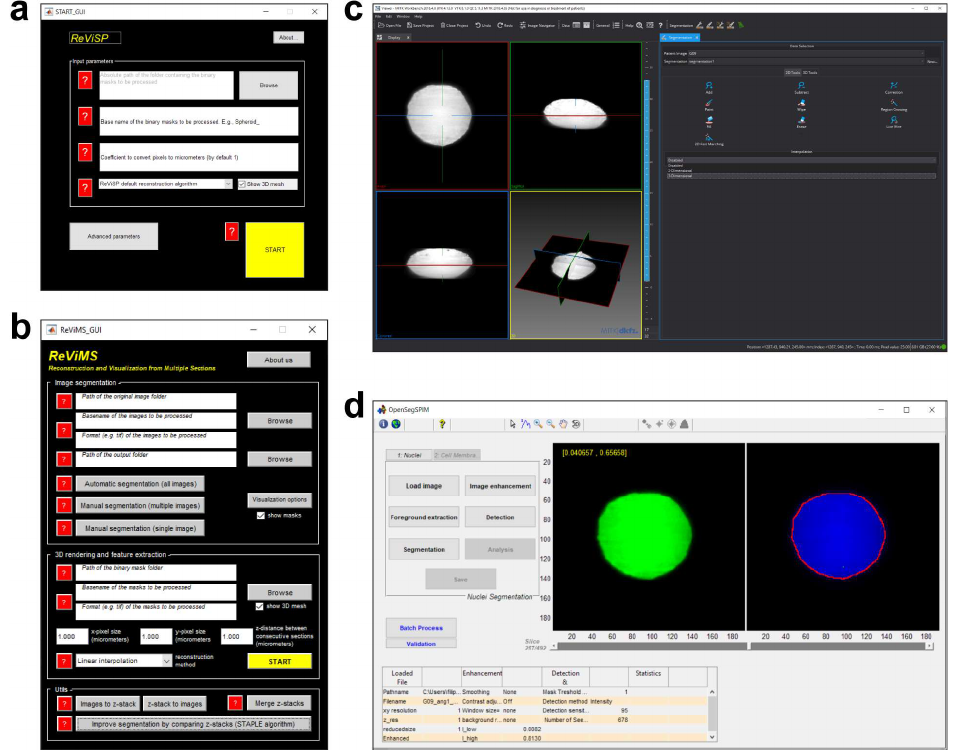
Figure 1. Screenshot of the Graphical User Interface (GUI) of the tools considered in this work. ( a ) ReViSP version 2.1; ( b ) ReViMS version 2.0; ( c ) MITK version 2018.04; ( d ) OpenSegSPIM version